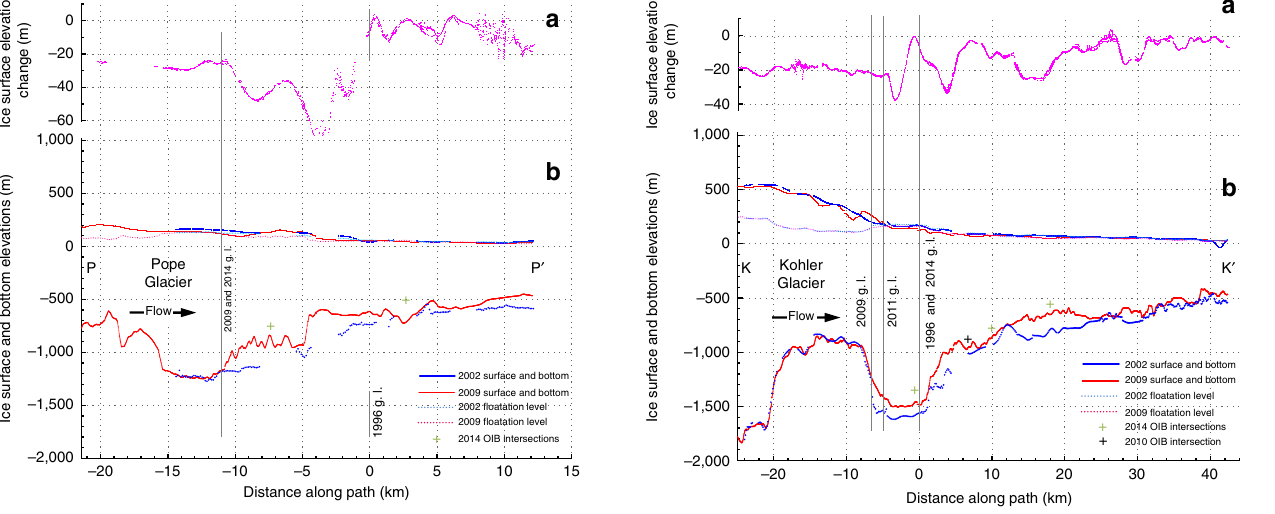
Fig. 2; Supplementary Table 1).